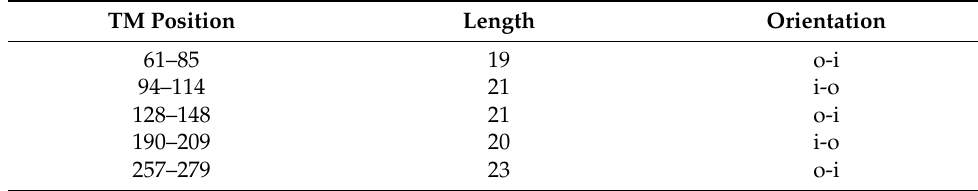
Figure 2. ( A , C ) 3D predicted model of the EoFAD2 protein; ( B ) Predicted transmembrane domains in FAD2 by TMHMM server (CBS; Denmark). Table 7. Transmembrane domains as predicted by